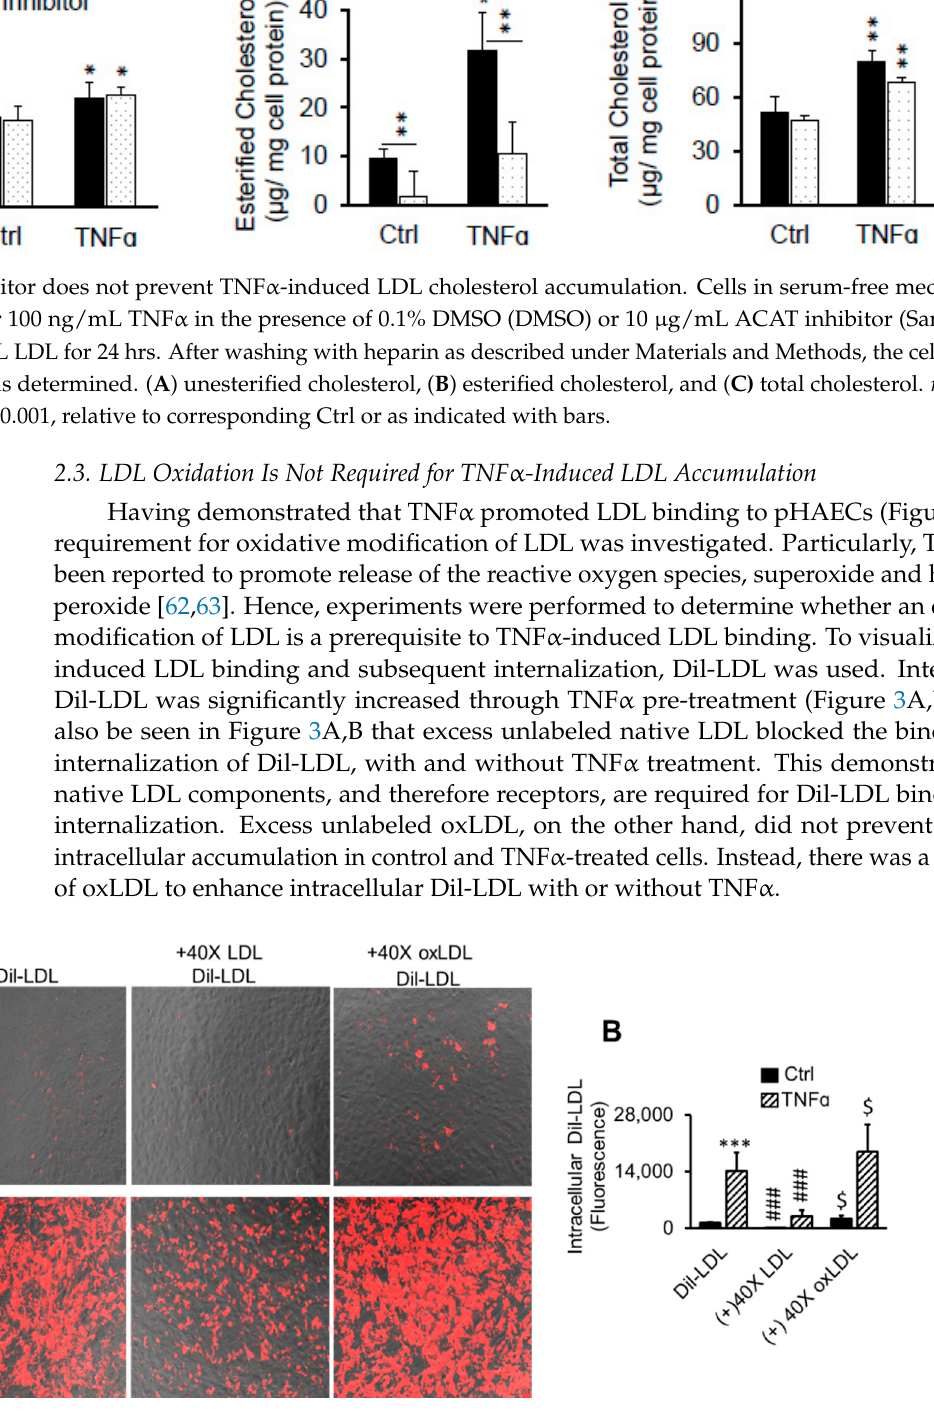
Figure 3. LDL oxidation is not required for TNF ɑ -induced LDL accumulation. ( A , B ) Cells were treated with 0 (Ctrl) or 100 ng/mL TNF ɑ (TNF ɑ ) for 24 h in serum medium. The media were replaced with serum-free media in the continued presence of TNF ɑ for 2 h to remove surface lipoproteins. Finally, 5 µg/mL Dil-LDL in serum-free medium (Dil-LDL) ± 40 times LDL (+40X LDL) or oxLDL (+40X oxLDL) was added, followed by 3 h incubation. The images are 20× magnifications. n = 3. ***, p < 0.001 vs. Ctrl. $, ###, p < 0.05, 0.001, relative to Dil-LDL alone.